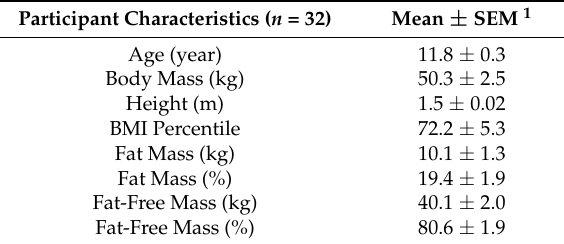
Table 1. The baseline characteristics of the participants.